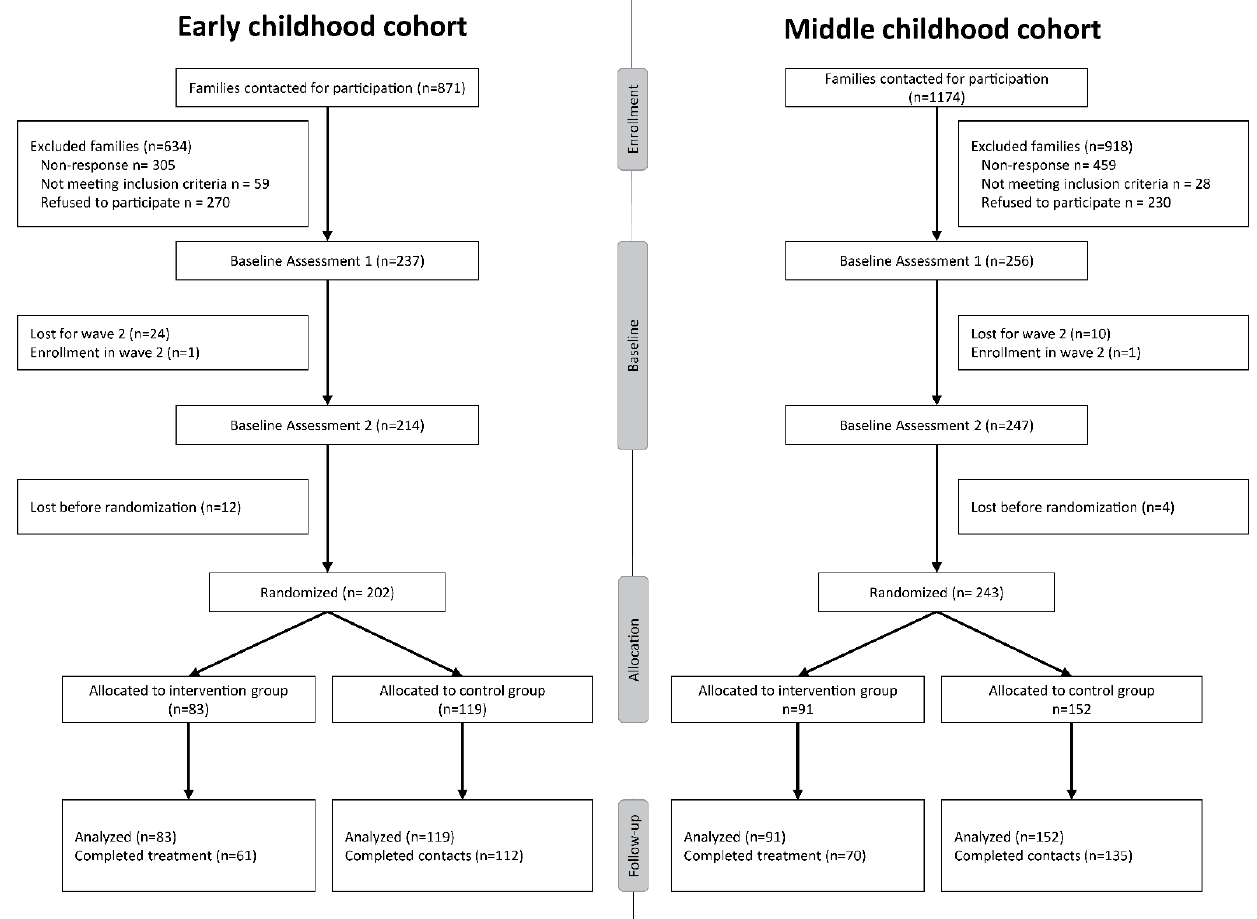
Figure 1. Flow chart of the randomized controlled trial with VIPP-SD in both twin cohorts. Number of participants reflects the number of families (including two twin children).